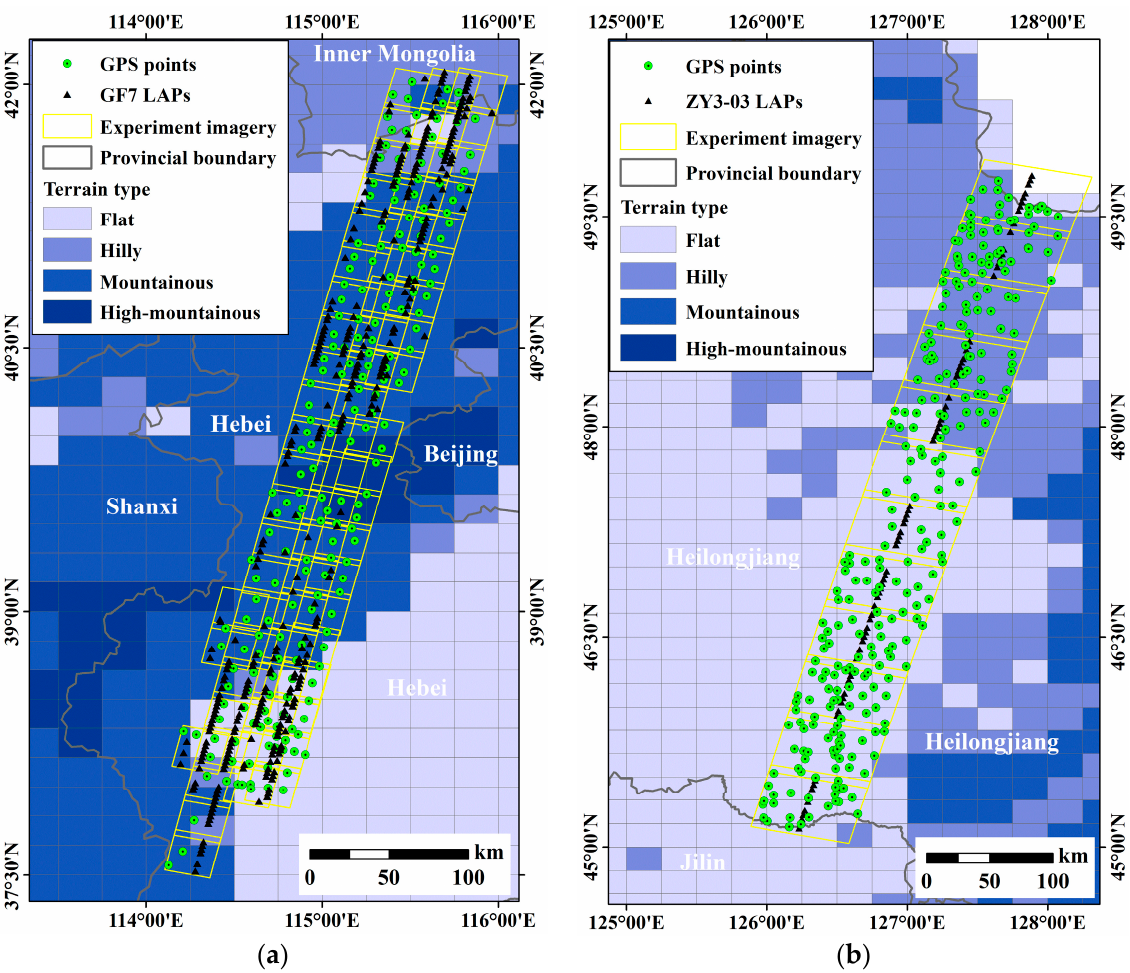
Figure 6. Geographical distributions of the experimental regions and data: ( a ) GF7 satellite data, ( b ) ZY3-03 satellite data.